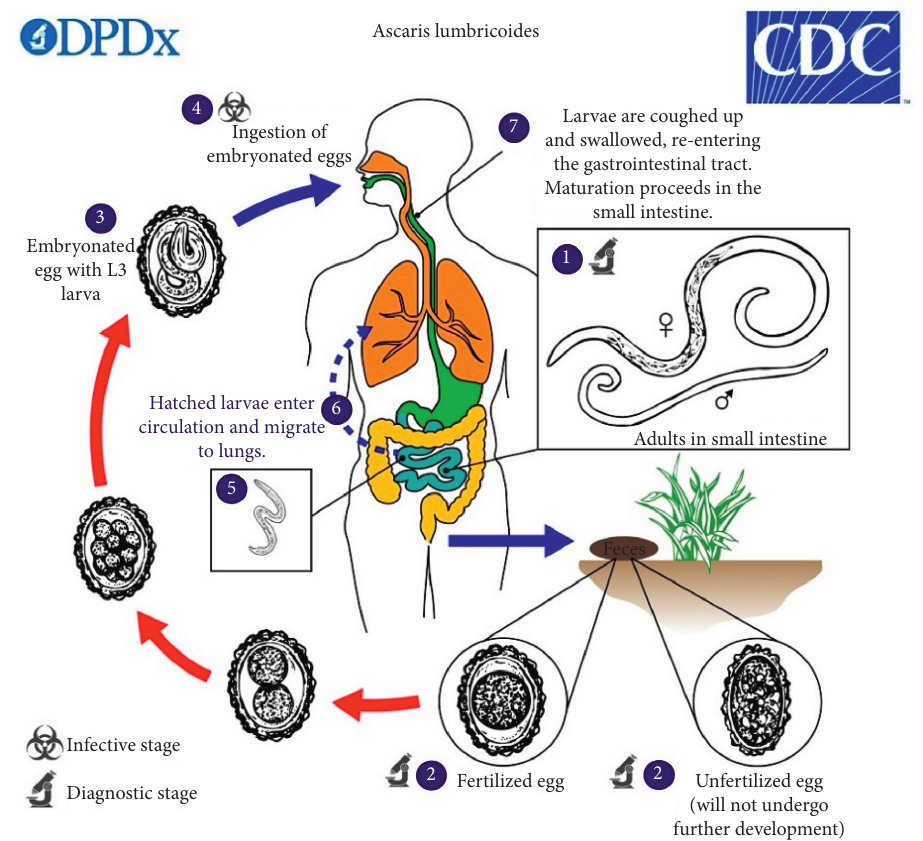
Figure 2: The life cycle of Ascaris lumbricoides summarized (source: Centers for Disease Control and